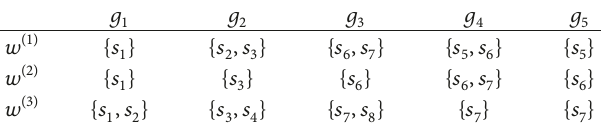
Table 4: Attribute weights information matrix [16].